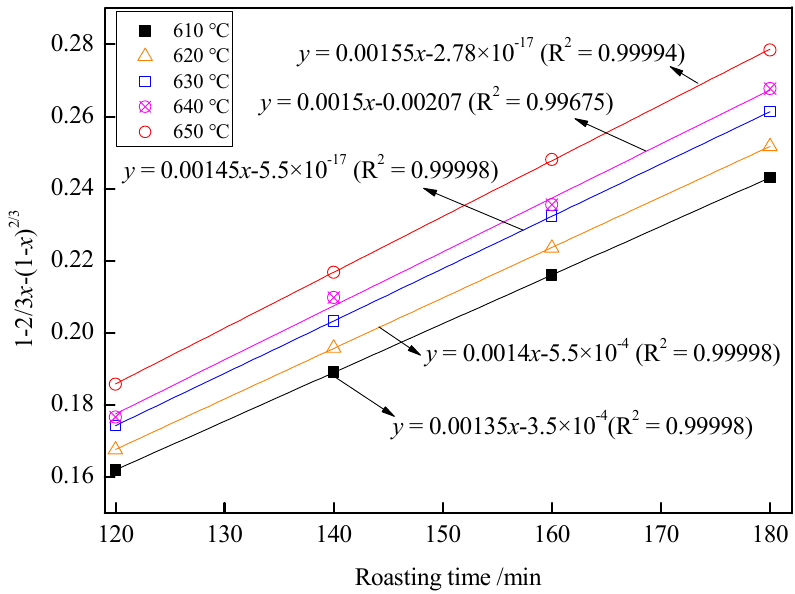
Figure 13. The relationship between the roasting time and 1 − 2/3 x − (1 − x ) 2/3 .